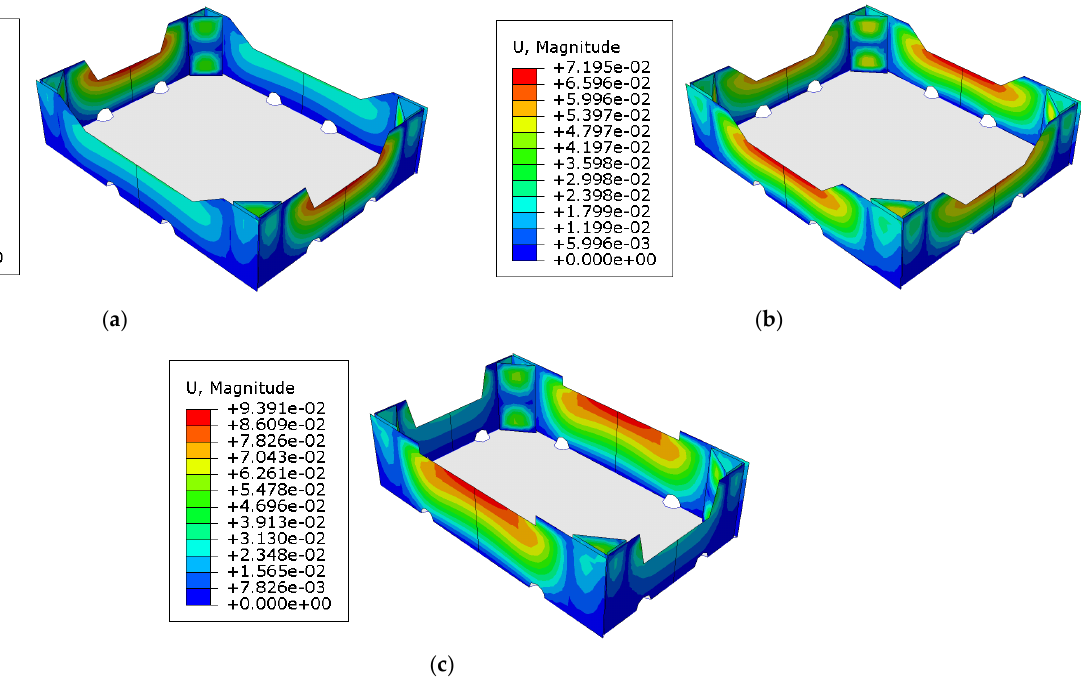
Figure 6. Selected buckling modes used for nominal strength analysis using the finite element method: ( a ) case 1, ( b ) case 19, and ( c ) case 20.